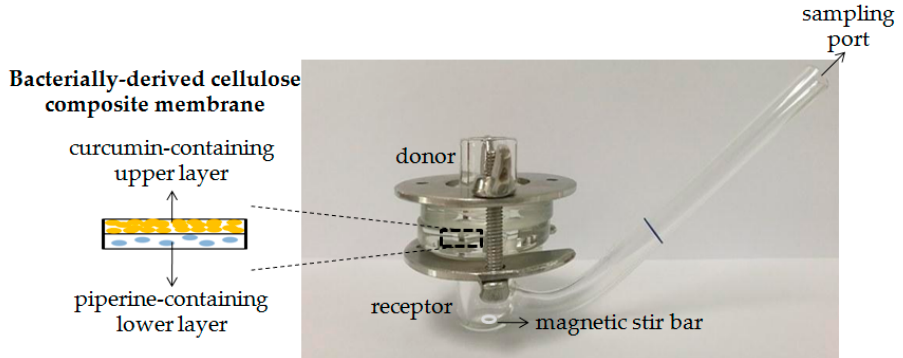
Figure 1. Schematic of the modified Franz diffusion cell assembled for release study.